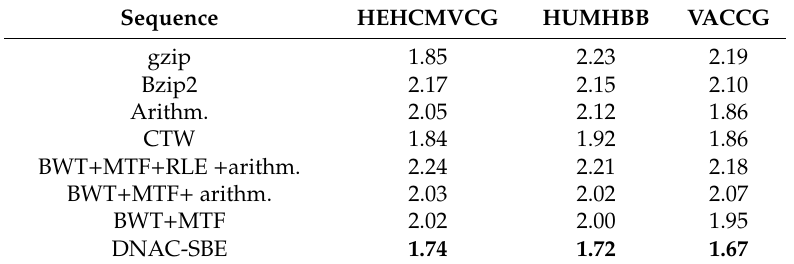
Table 5. Performance comparison between various text compression algorithms and some of Burrows–Wheeler transform (BWT) based algorithms in terms of compression ratio